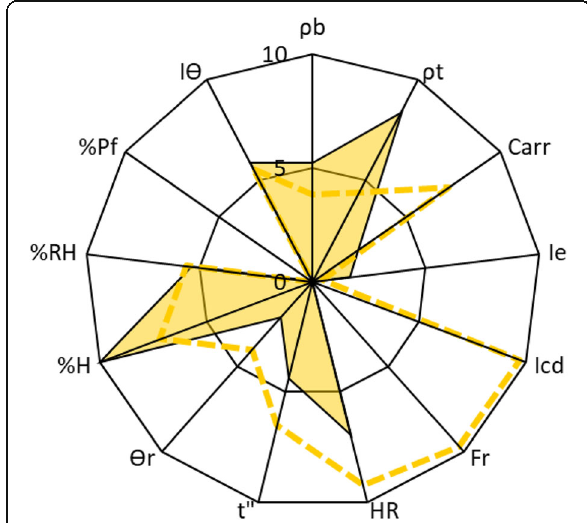
Fig. 2 Superimposed SeDeM diagrams of MCC (dotted lines) and corn starch (shaded